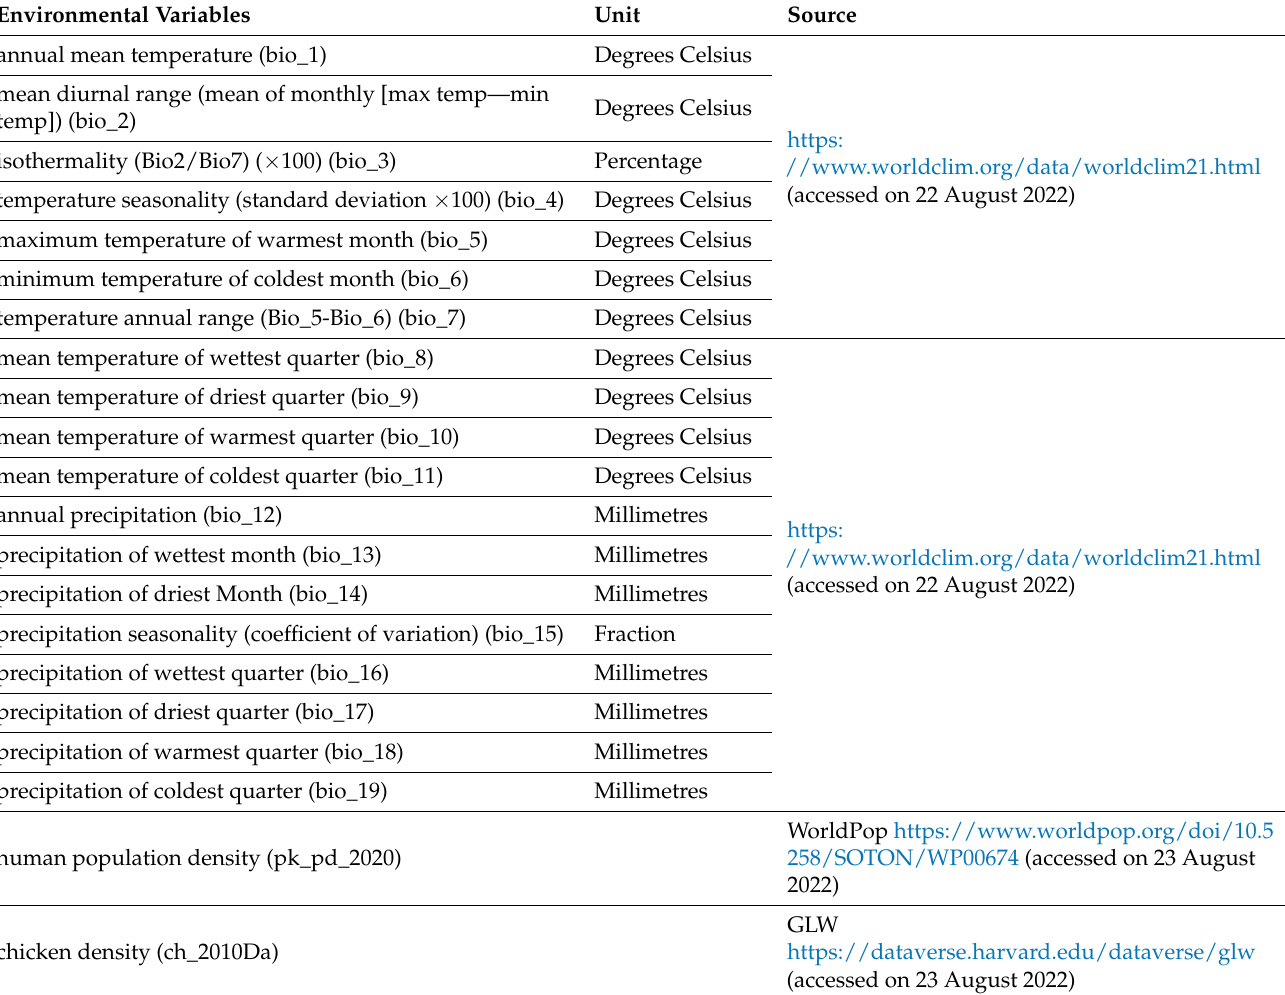
Table 1. List of environmental variables used in modelling potential habitats for steppe eagles in